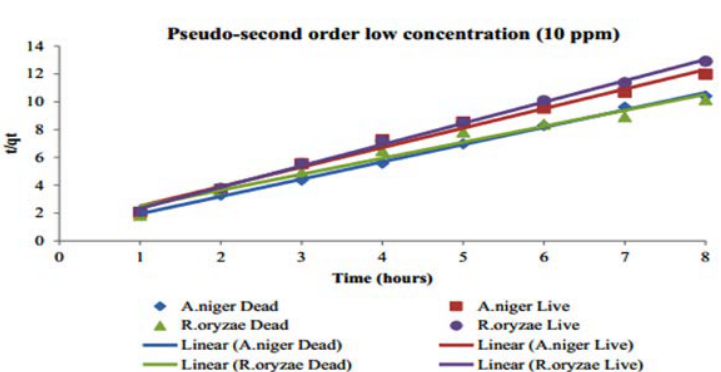
Fig. 13 . The Pseudo-second-order at low concentration (10 ppm)